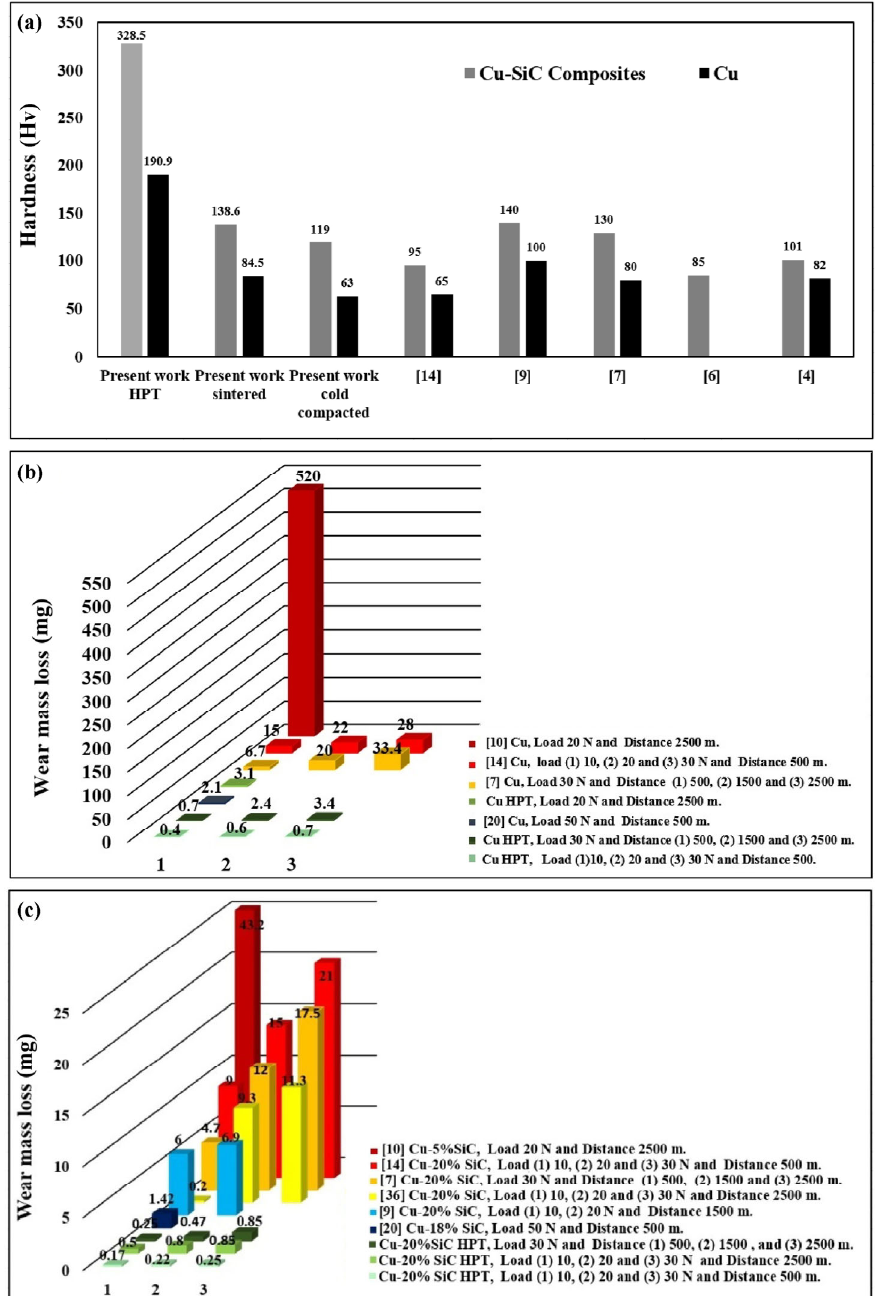
Fig. 5 Comparison between (a) hardness and wear mass loss of HPTed (b) Cu and (c) Cu-SiC samples with previous works concerned with fabrication of micro size Cu and Cu composites